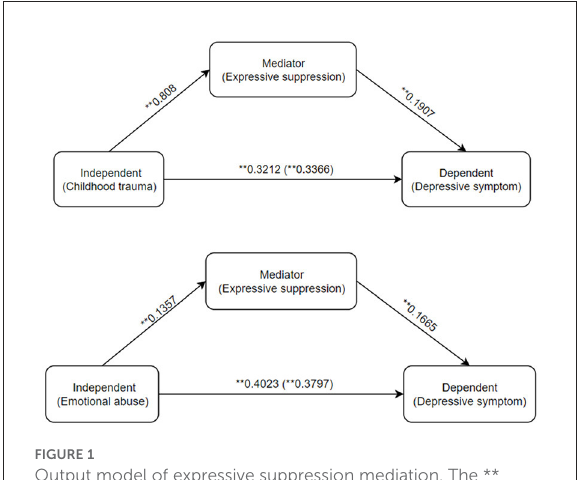
FIGURE1 Output model of expressive suppression mediation. The ** symbol indicates the mediating effect is significant at the 0.01 level